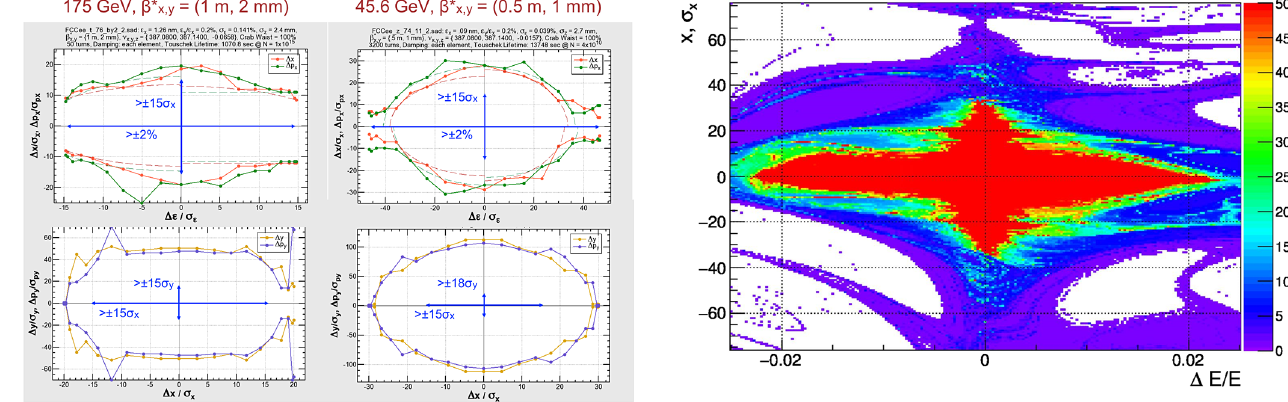
FIG. 11. Dynamic aperture for FCC-ee interaction region variant 1.